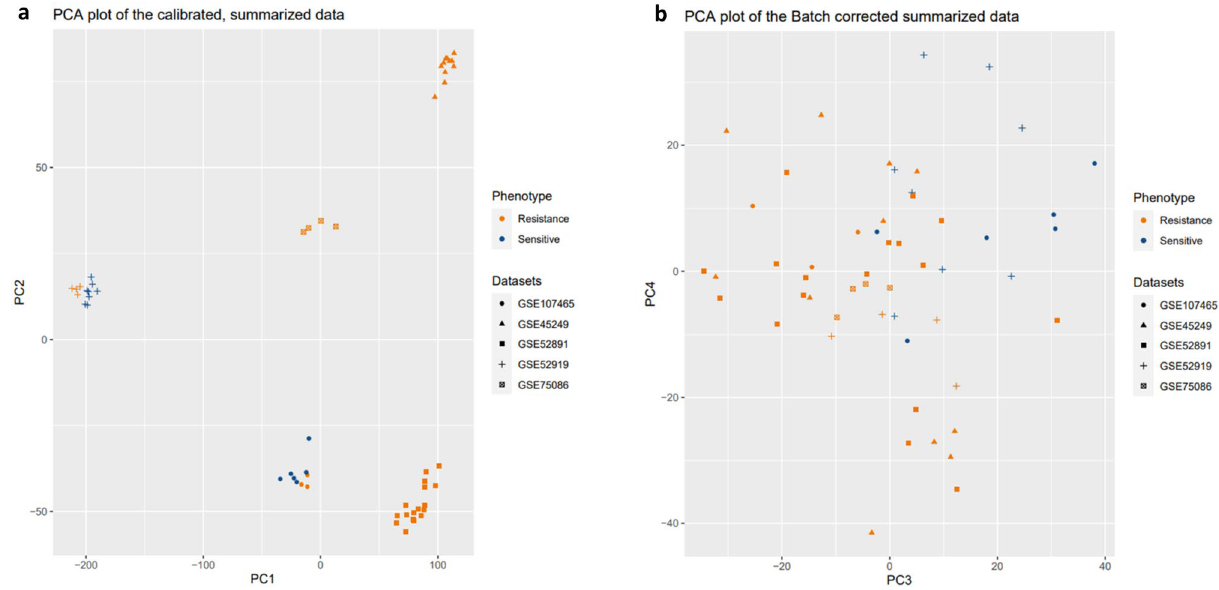
Figure 2. PCA plot of the summarized data by batch correction. Scatter plots of principal components analysis (PCA) show the PC1 versus PC2 output for each calibrated AML samples of included datasets before batch correction procedure ( a ), and PC3 versus PC2 output after batch correction ( b ). PCA plots illustrate the similarity of gene expression profiles among samples using the ggplot2 package version 3.3.3 in R 74